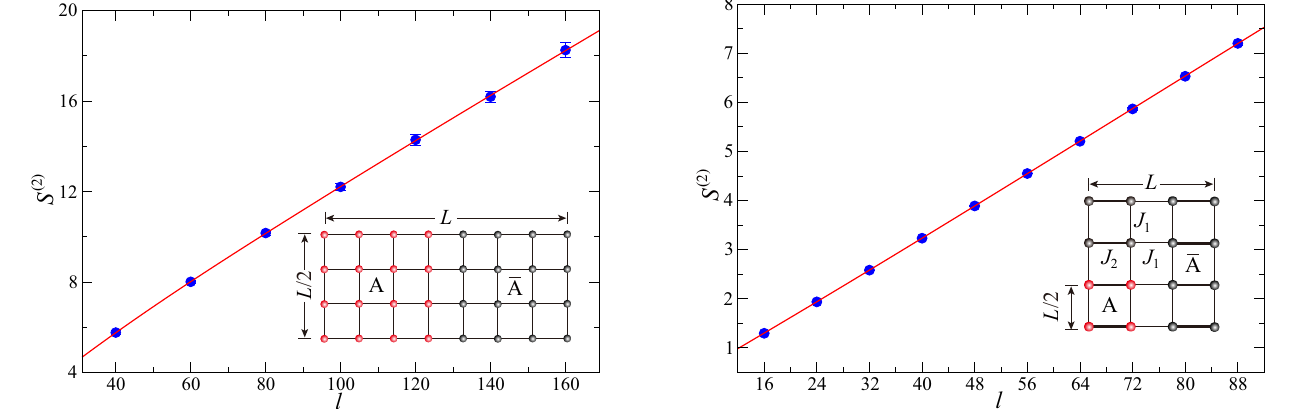
Fig. 2 Entanglement entropy at O(3) criticality. Second Rényi Fig. 1 Identi fi cation of Goldstone modes. Second Rényi entangle- entanglement entropy of the square lattice J 1 − J 2 columnar ment entropy of two dimensional L ´ L Heisenberg model for 2 dimer model for different system sizes. The entanglement region different system sizes. The inset shows the entanglement region A is ´ L ´ L A is chosen to be a L square with four corners and boundary chosen to be a L cylinder on the torus without corners and with 2 2 2 2 length 2 L . The corners contribute to the universal log-correction boundary length (area) L . The temperatures are chosen to be 1/ T = L . with the coef fi cient β related to the central charge of the ð L Þ ¼ 0 : 092 ð 1 Þ L þ 1 : 00 ð 9 Þ ln ð L Þ (cid:2) 1 : 63 ð 3 Þ for The fi tting result is S ð 2 Þ A underlying CFT of the O(3) transition. The fi tting result is L ∈ [40, 160]. The standard error of the mean (SEM) is used when ð L Þ ¼ 0 : 167 ð 2 Þ L (cid:2) 0 : 081 ð 4 Þ ln ð L Þ (cid:2) 0 : 124 ð 7 Þ . SEM is used when S ð 2 Þ estimating the errors of the physical quantities. A estimating the errors of the physical